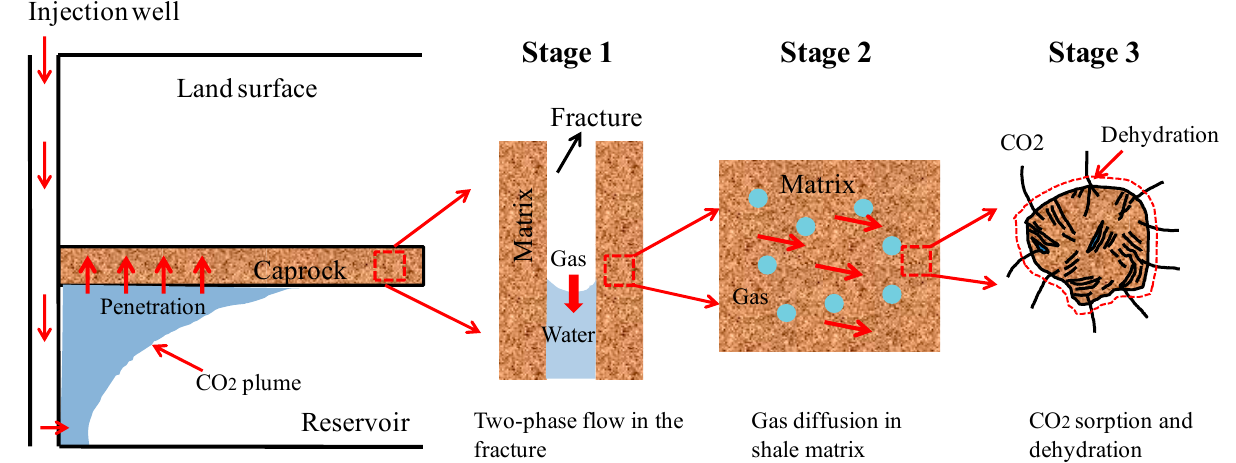
Figure 1. CO 2 transport and dehydration mechanism of shale caprock.